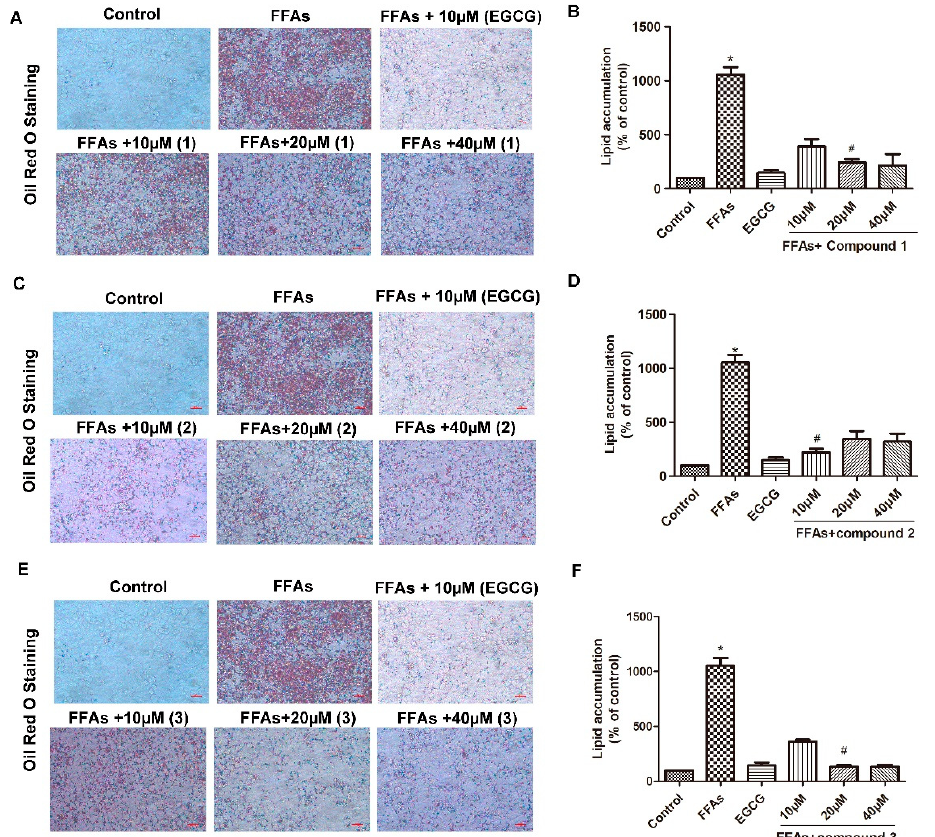
Figure 3. Effect of isolated compounds on steatosis in FFAs-exposed HepG2 cells. The HepG2 cells were treated with FFAs (oleate/palmitate, 2:1 ratio, 0.3 mM) for 24 h, then treated with compounds 1 – 3 for 24 h. ( A ) Compound 1 reversed the effect of FFAs on lipogenesis; ( B ) Lipid accumulation area values. ( C ) Compound 2 reversed the effect of FFAs on lipogenesis; ( D ) Lipid accumulation area values. ( E ) Compound 3 reversed the effect of FFAs on lipogenesis; ( F ) Lipid accumulation area values. ( − )-Epigallocatechin gallate (EGCG) is a positive control group; Oil Red O staining showed lipid accumulation, original magnification ×400; Values are mean ± SD ( n = 3). * p < 0.05 vs. control, # p < 0.05 vs. FFAs.